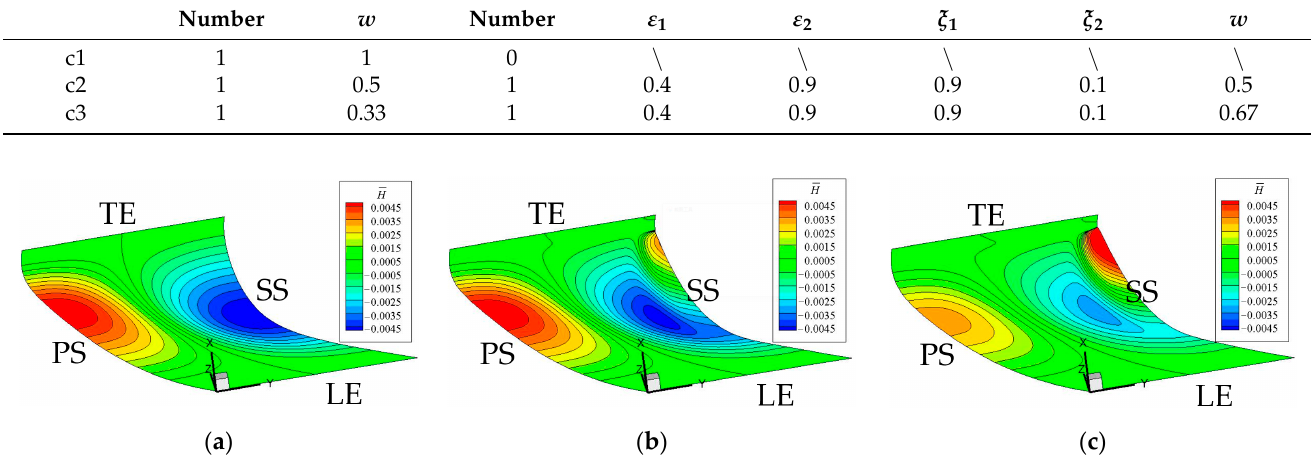
Figure 8. The geometry of the end wall contouring cases: ( a ) case c1; ( b ) case c2; ( c ) case c3. Figure 9 gives the variation of the overall total pressure loss ( c p ) with incidence ( i ) for the three end wall contouring cases. The working condition with i = − 1° is the design point.